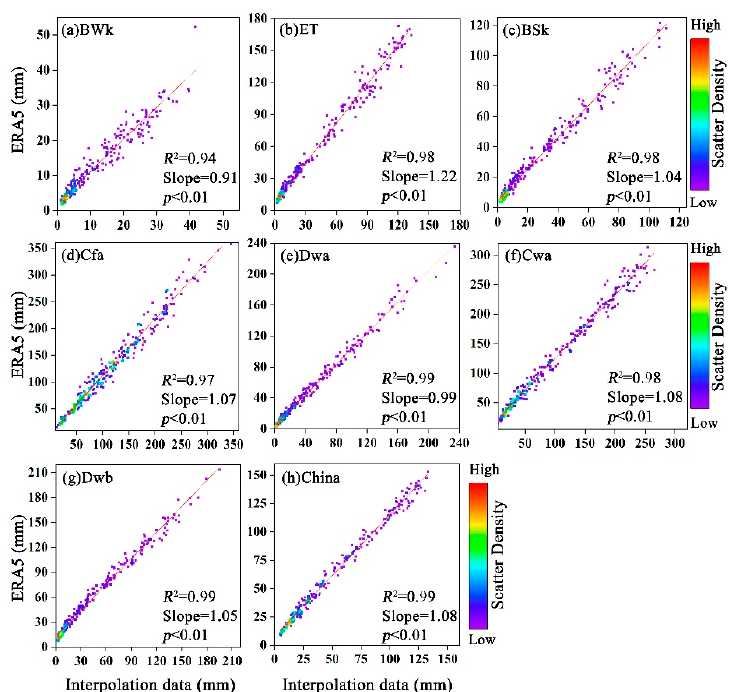
Figure 12. Comparison and verification of interpolation data and the European Centre for Medium- Range Weather Forecasts Reanalysis 5 (ERA5) data of temperature for selected Köppen–Geiger clas- Table 3 for explanations of the abbreviations).